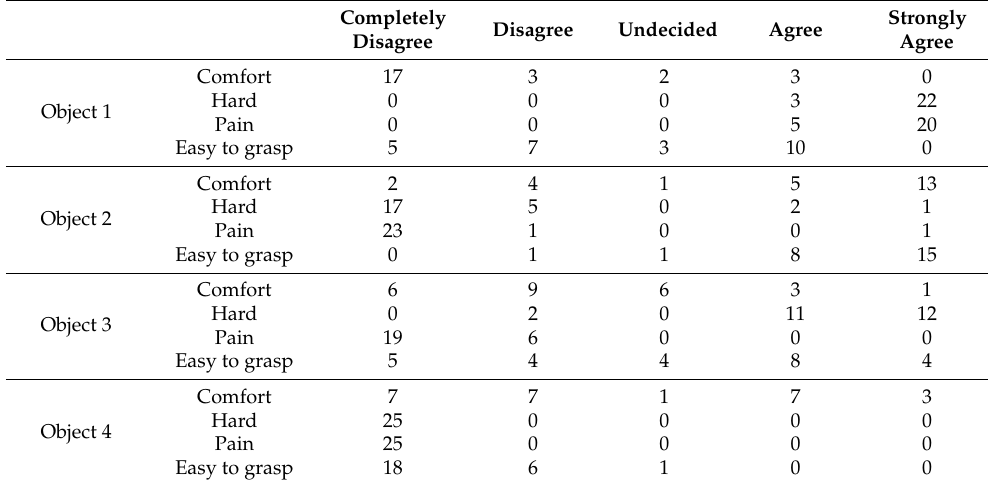
Table 1. Results of the questionnaire for each